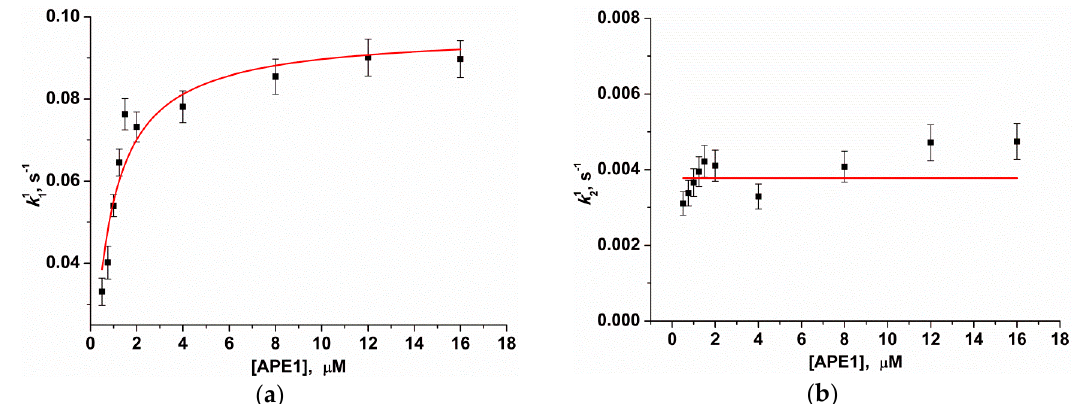
Figure 5. Dependences of the observed rate constants k 11 ( а ) and k 21 ( b ) on APE1 concentration. Data presented in ( a ) and ( b ) were fitted to a hyperbolic equation (Equation (1)) or to a linear function, respectively.